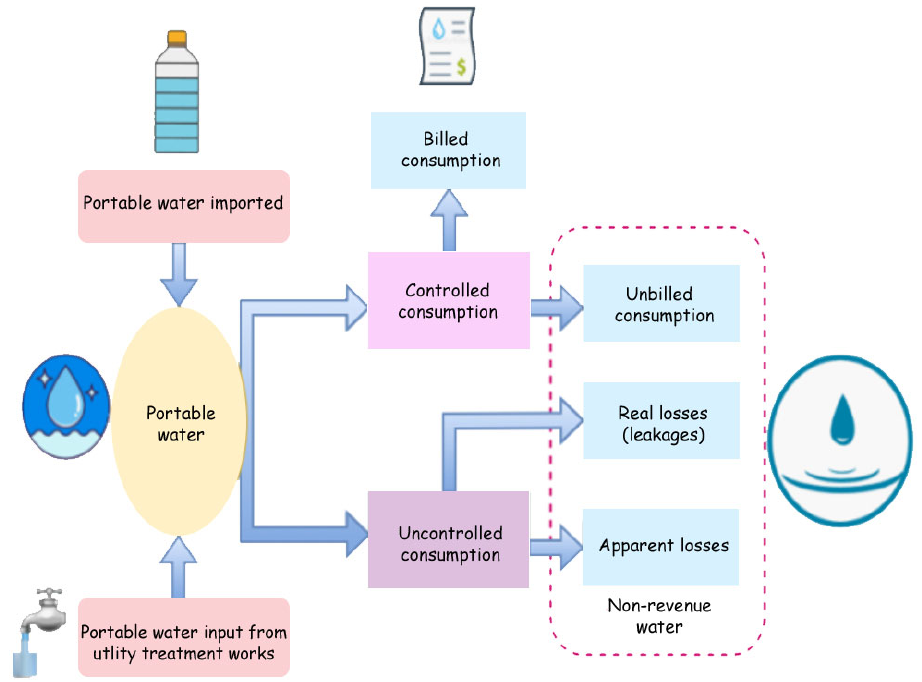
Figure 4. Drinking water distribution for residential buildings.